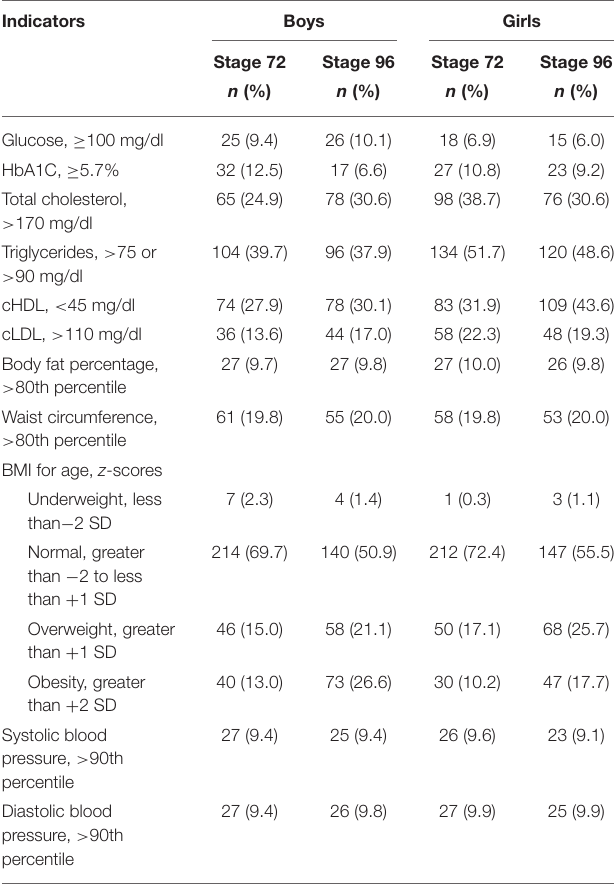
TABLE 2 | Children’s metabolic syndrome risk factors by sex and study visit. Indicators